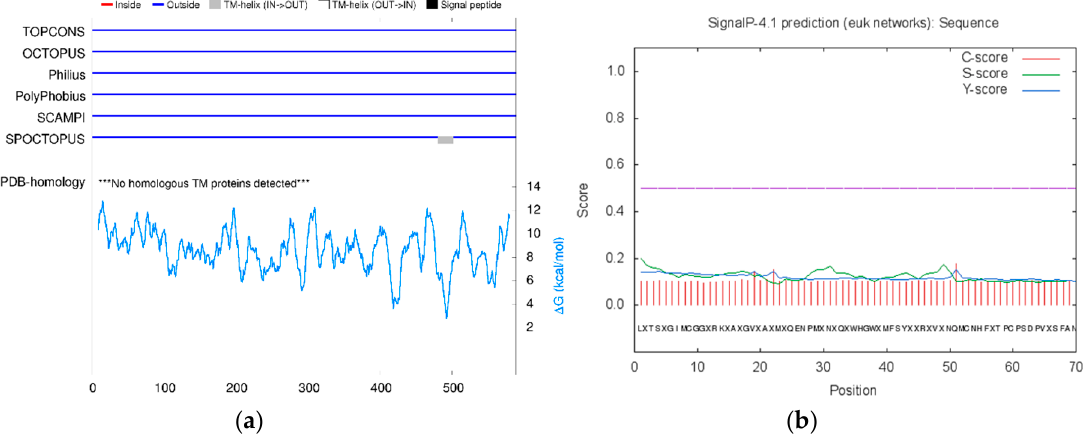
Figure 1. Results from ( a ) TOPCONS and ( b ) Signalp4 showed that ACE is present outside of the cell membrane and has no signal peptide.